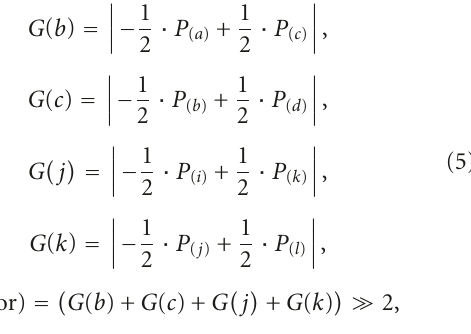
Figure 10(b) is an intensity gradient filter orientation for four pixels ( b , c , j , and k )